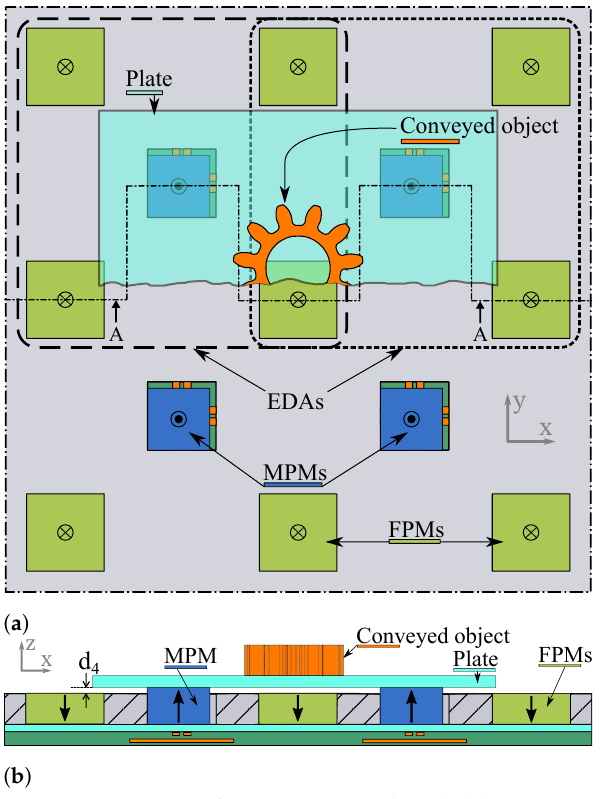
Figure 2. 2 × 2 Digital Actuator Array (DAA). ( a ) Top view. ( b ) Front view (A-A cut).